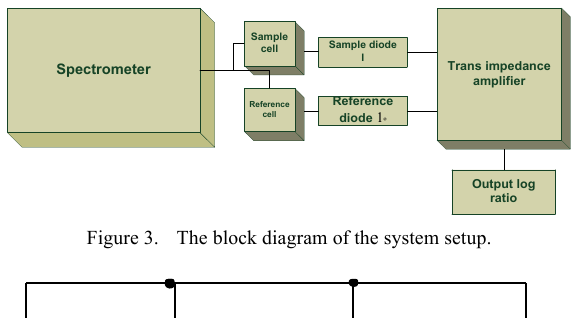
Figure 2. Picture of the optical system based on the Czenry turner configuration